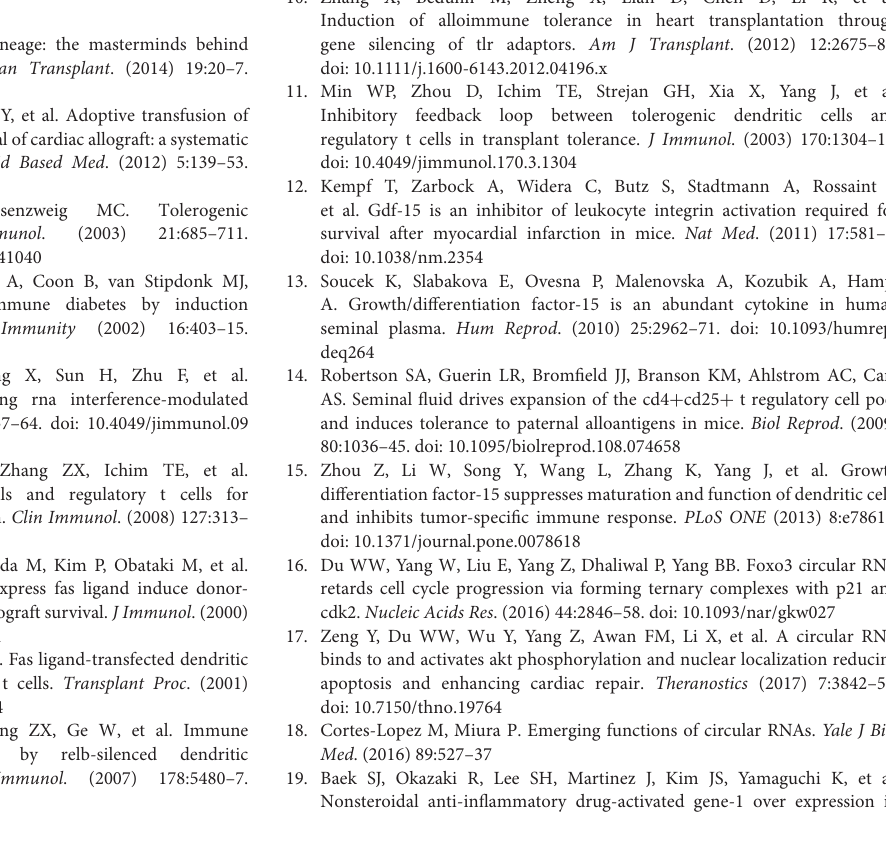
Supplemental Table 1 | Primer sequences for qPCR.